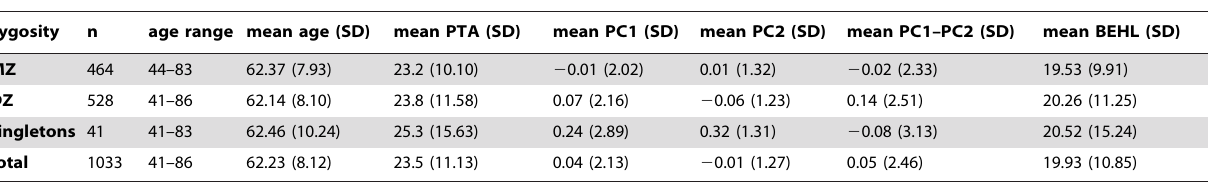
Table 1. Demographic and phenotypic profile of study sample with pure-tone audiogram data.